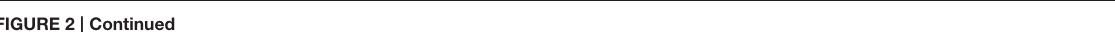
FIGURE 2 | Continued revealed thickly dotted CCMs distributed throughout the cerebral cortex in the brain of the proband. There are dozens of lesions on the cerebrum, cerebellum, thalamus, and brain stem. The diameter of the lesions ranges from a few millimeters to several centimeters. (E) SWI-MR imaging of the proband’s elder brother, II-2. II-2 showed a similar phenomenon, with multiple CCM lesions observed upon SWI-MRI of the brain. (F) SWI-MR imaging of the proband’s younger sister, II-3. II-3 did not show any CCM lesions upon SWI-MRI of the brain.